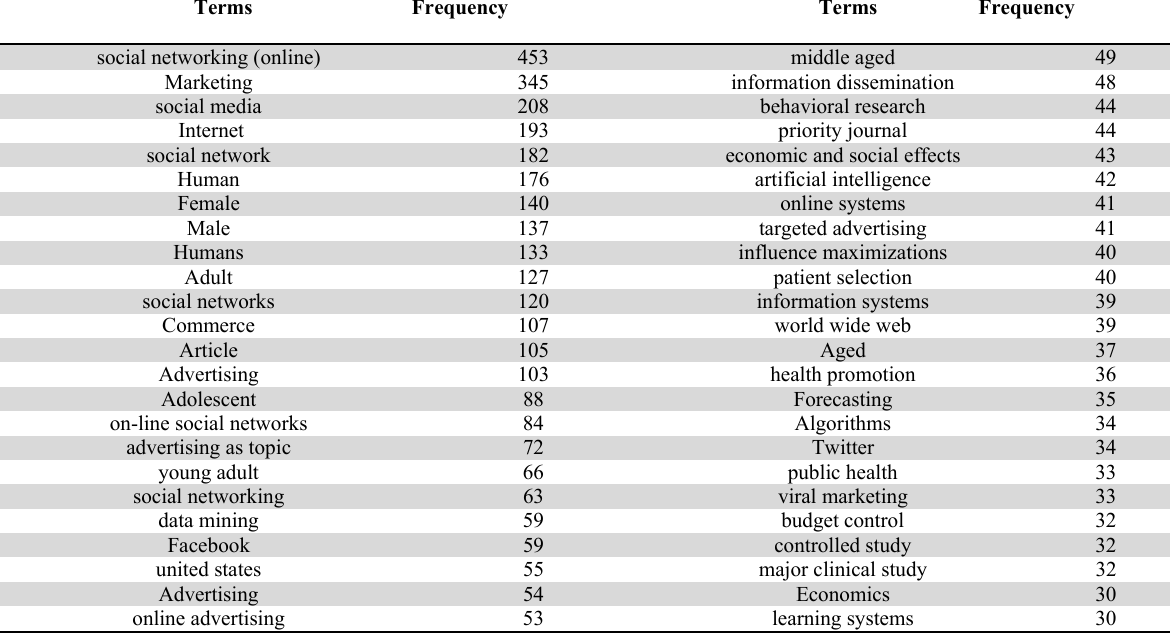
The most popular keywords used in studies associated with advertising in social